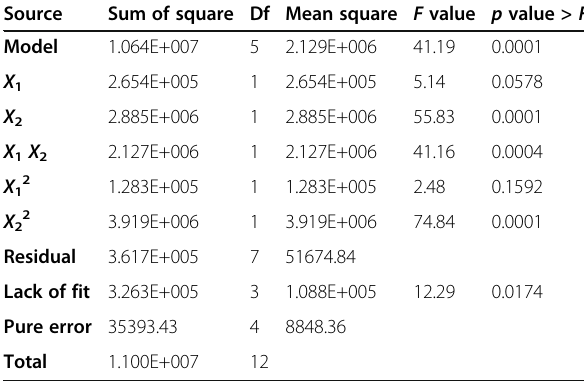
Table 6 Face-centered CCD ANOVA results for peak area